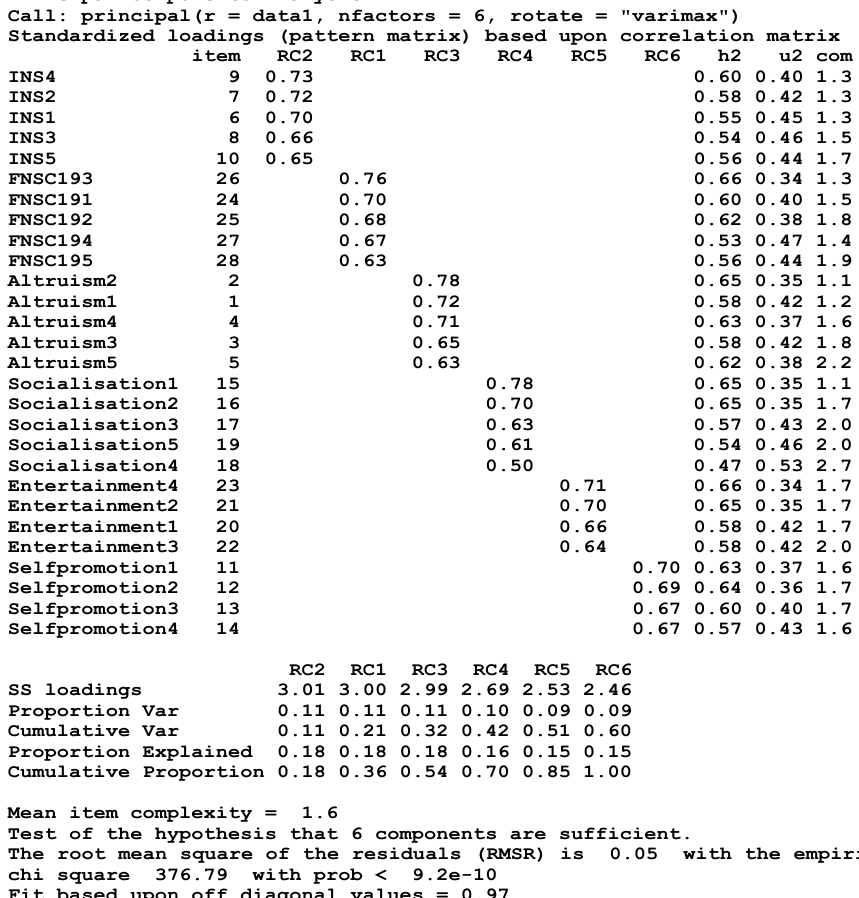
Standardized loadings (pattern matrix) based upon correlation matrix item